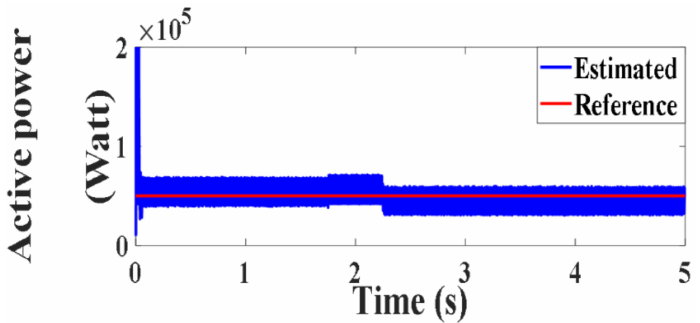
Figure 38. Active power under MPDTC (Watt).